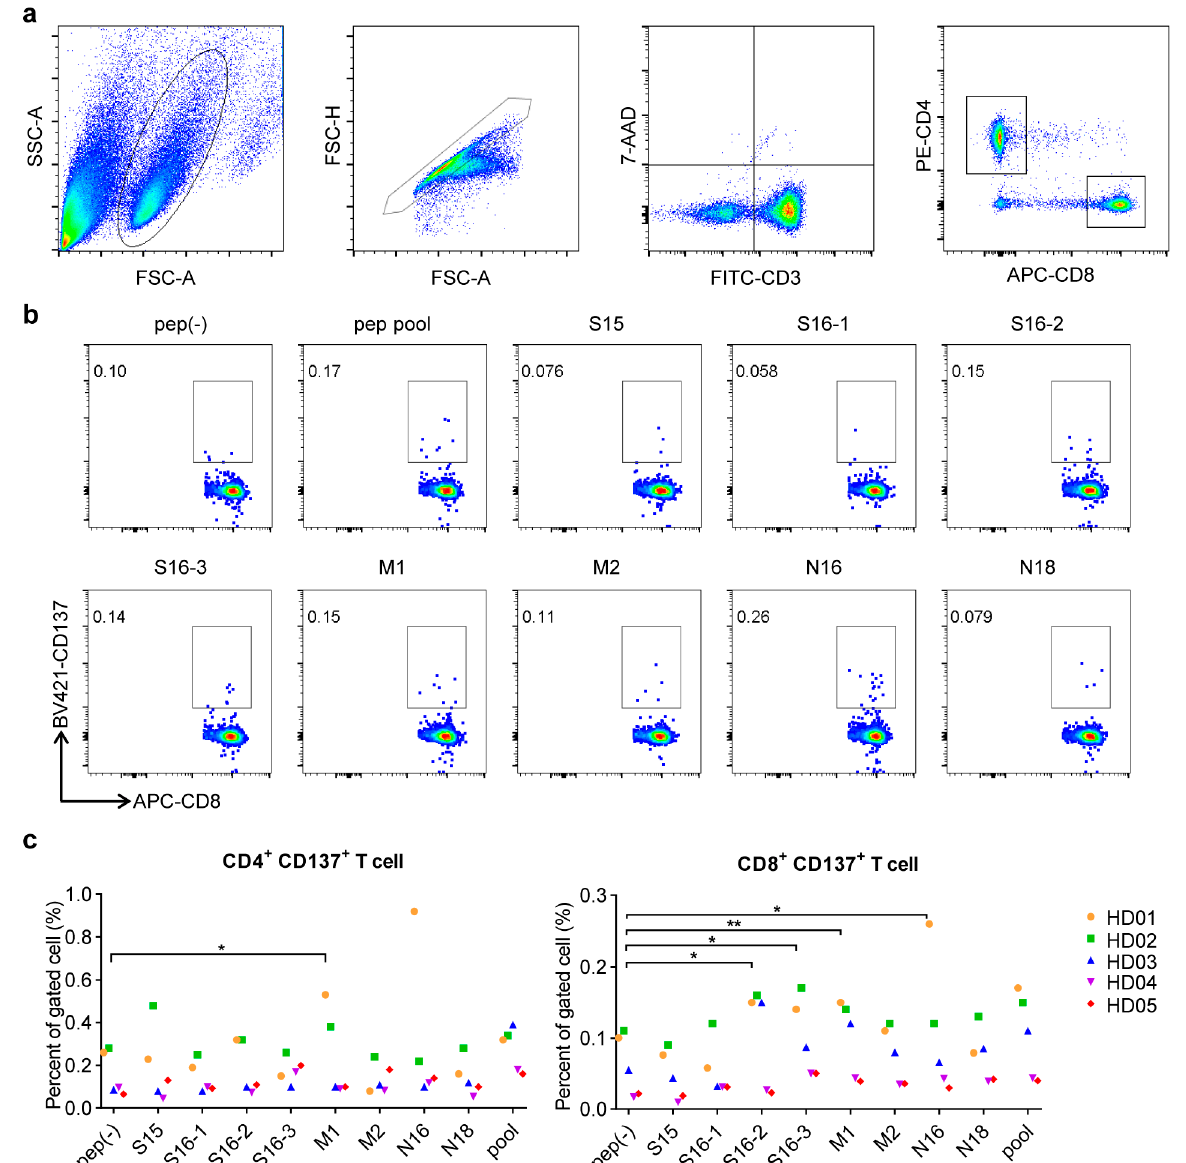
Figure 2. T cell immune responses to SARS ‐ CoV ‐ 2 conserved antigens. Peripheral blood mononuclear cells ( PBMCs) of 5 unexposed healthy donors were cultured with peptide pool for stimulation in vitro for 72 h, the T cell responses were assayed by flow cytometer. ( a ) Flow cytometry gating strategy. Only single, live, and CD8 or CD4 sole ‐ expressing T cells were Boolean gated and used for analysis. ( b ) Responses of CD8 + T cell from unexposed healthy donor 01 (HD01) to each peptide were assayed. ( c ) Statistical graph of the responses of CD4 + and CD8 + T cell from all the 5 unexposed healthy donors. Paired t ‐ test was used. (* p < 0.05, ** p < 0.01).